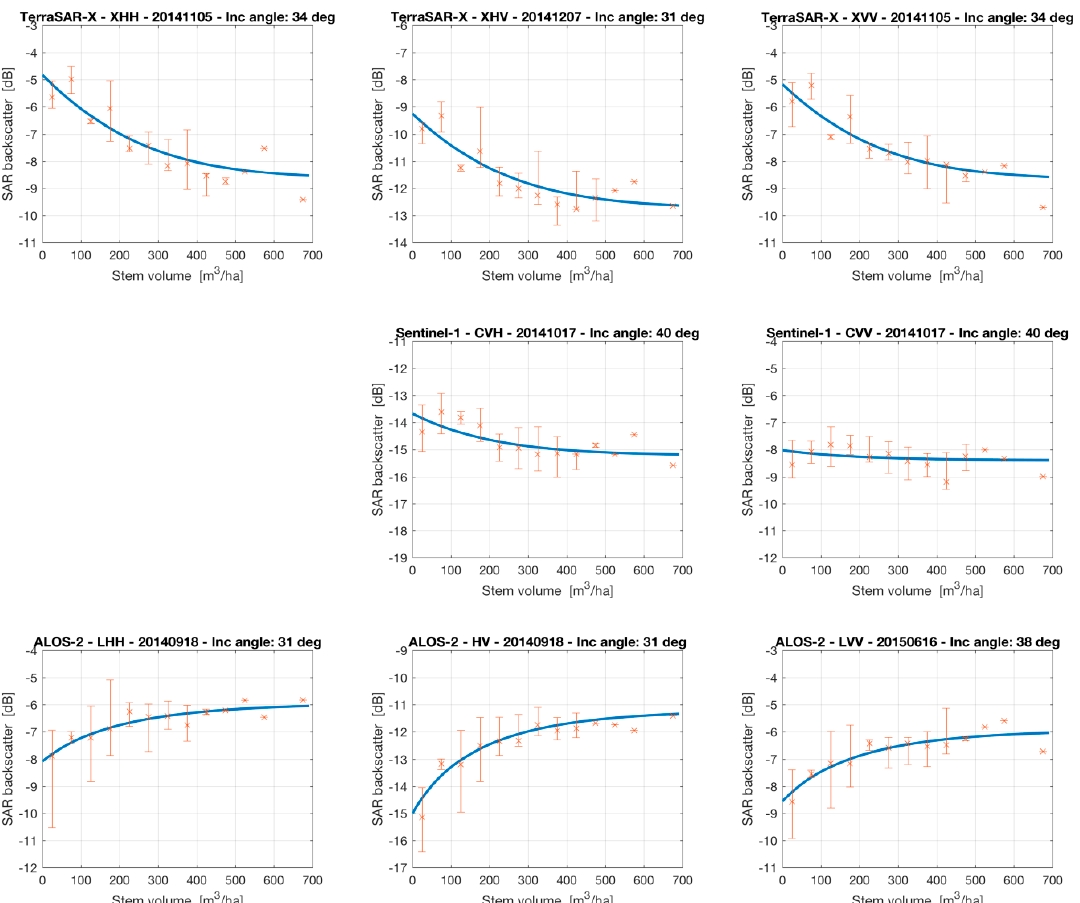
Figure 4. Measured and modeled SAR backscatter as a function of stem volume for the 48 0.5-ha forest plots at Remningstorp. Crosses and vertical bars represent the average and the range of SAR backscatter values in 50 m 3 / ha wide intervals of stem volume. The blue curves represent the Water Cloud Model (WCM) fitted to the observations.